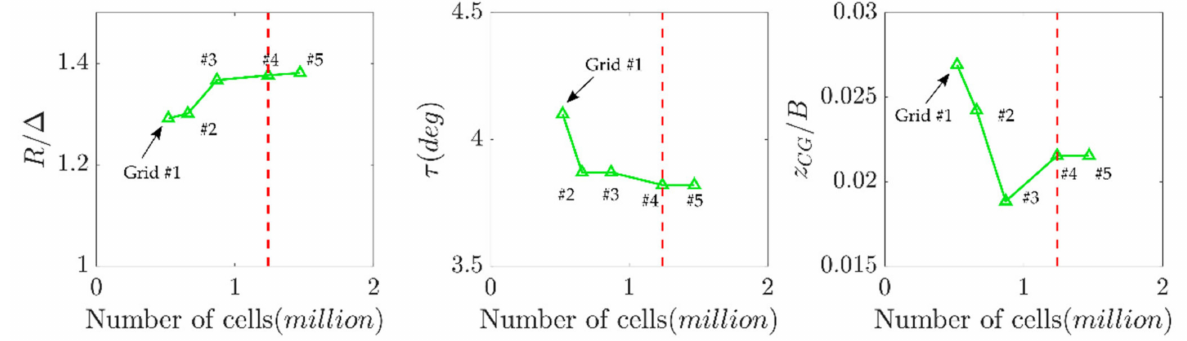
Figure 6. A sample of grid study performed in the current research. The presented results correspond to the morphing mesh case with turbulence model of k- ε at speed of 4 m/s (corresponding to the beam Froude Number of 1.48).Left, middle and right panels respectively refer to data corresponding to resistance, trim angle and C.G rise